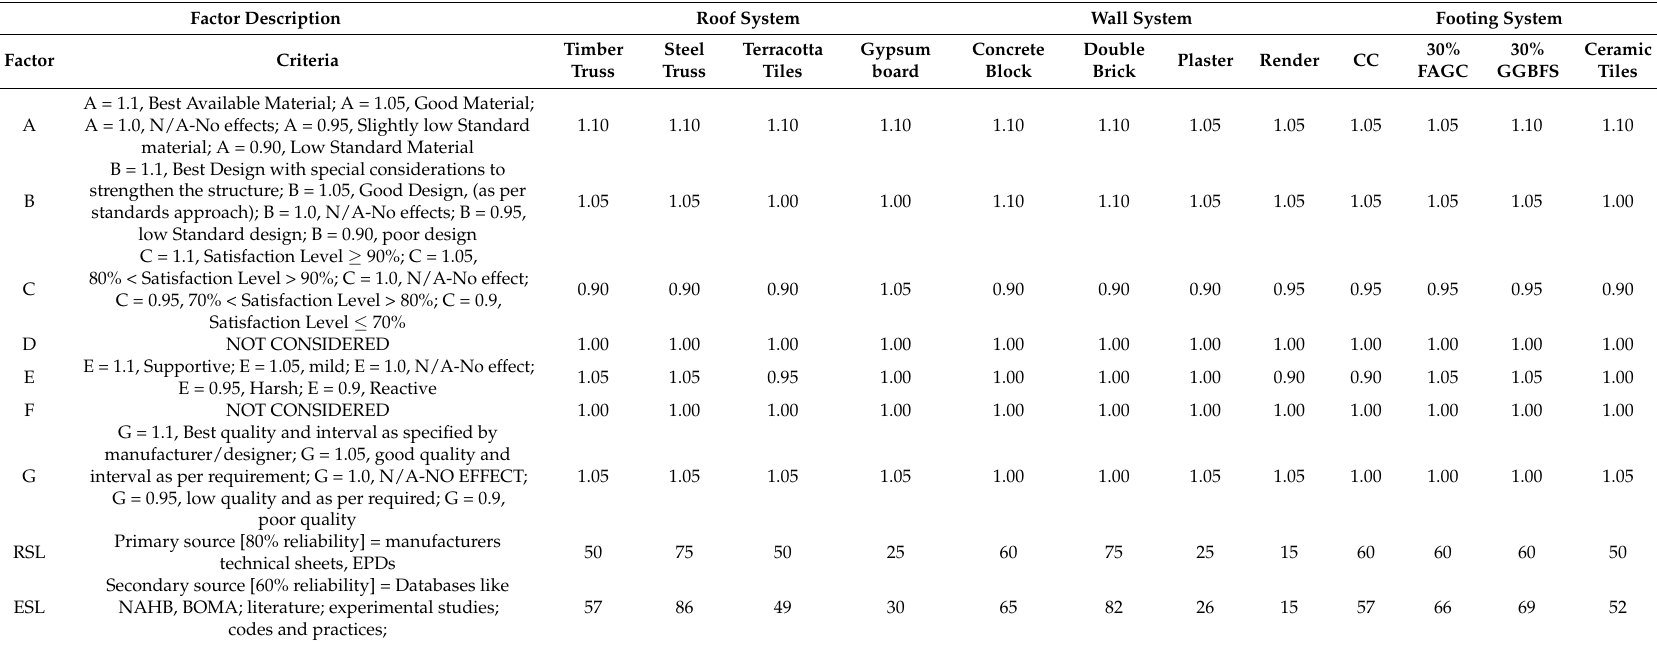
Table 3. Criteria and Coefficients of service life